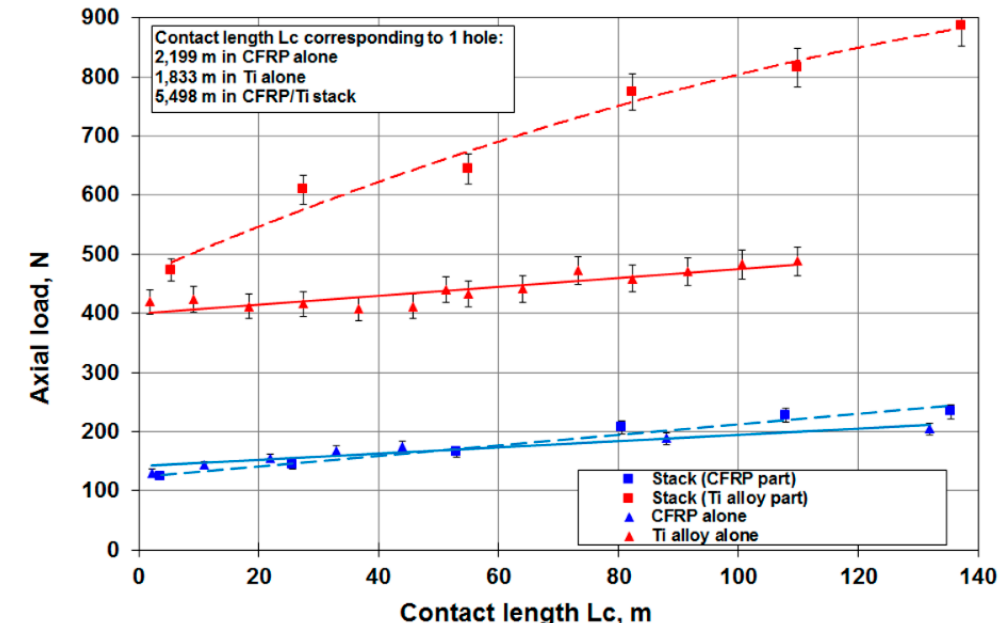
Figure 9. Axial load versus contact length Lc for CFRP and Ti alloy plates and the CFRP / TI alloy stack.